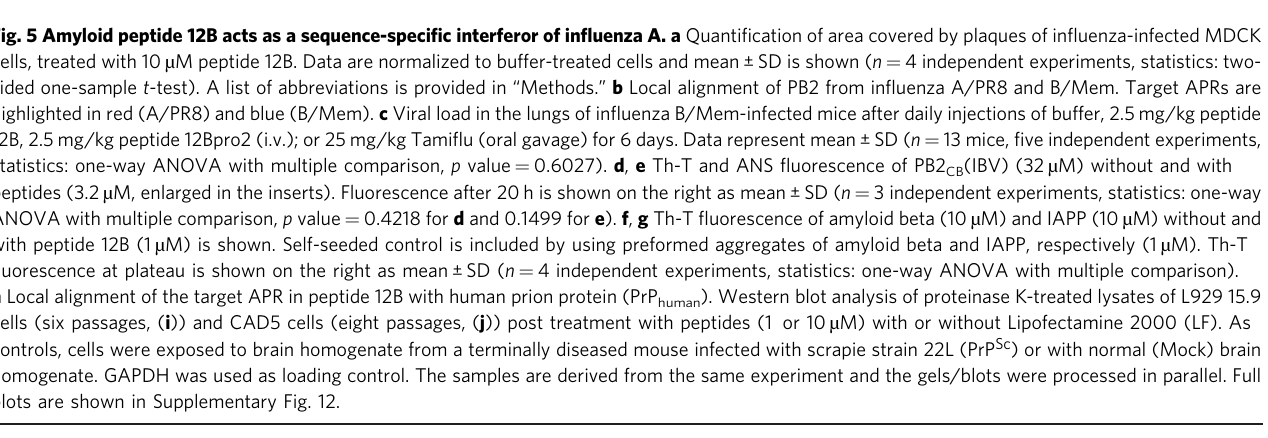
Fig. 5 Amyloid peptide 12B acts as a sequence-speci fi c interferor of in fl uenza A. a Quanti fi cation of area covered by plaques of in fl uenza-infected